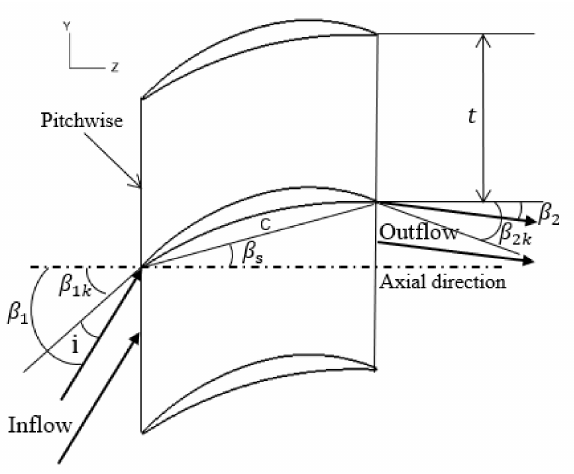
Figure 1. Airfoil of the original cascade. Table 1. Main geometric and aerodynamic parameters of the original